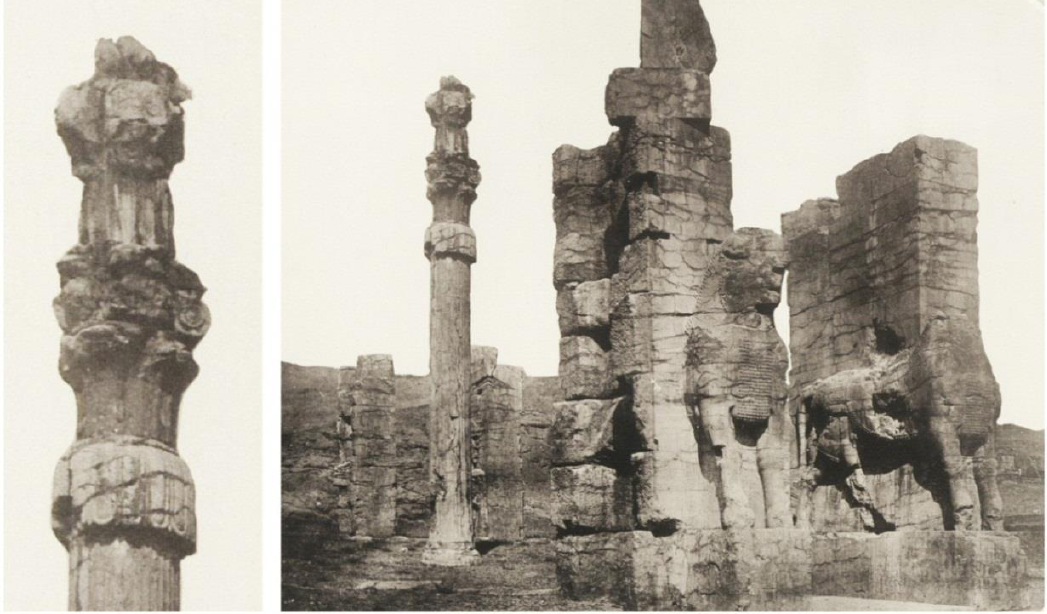
Figure 10. Deteriorated state of the zoophorous capital in 1882. Reference [44] (Plate. 87). Source: Staatbibliotek zu Berlin.